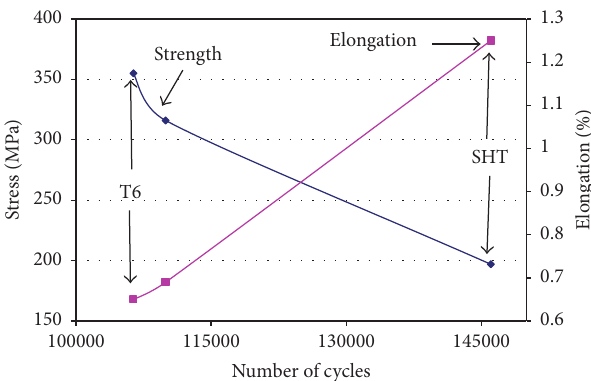
Figure 10: Dependence of number of cycles on the Mg content (%) in the as-cast condition.